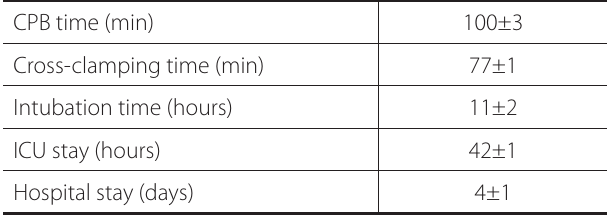
Table 2 . Surgical data.